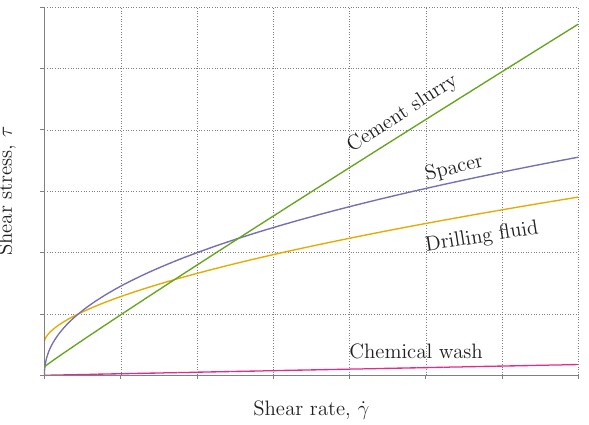
Figure 1: Example of typical flow curves for fluids involved in well